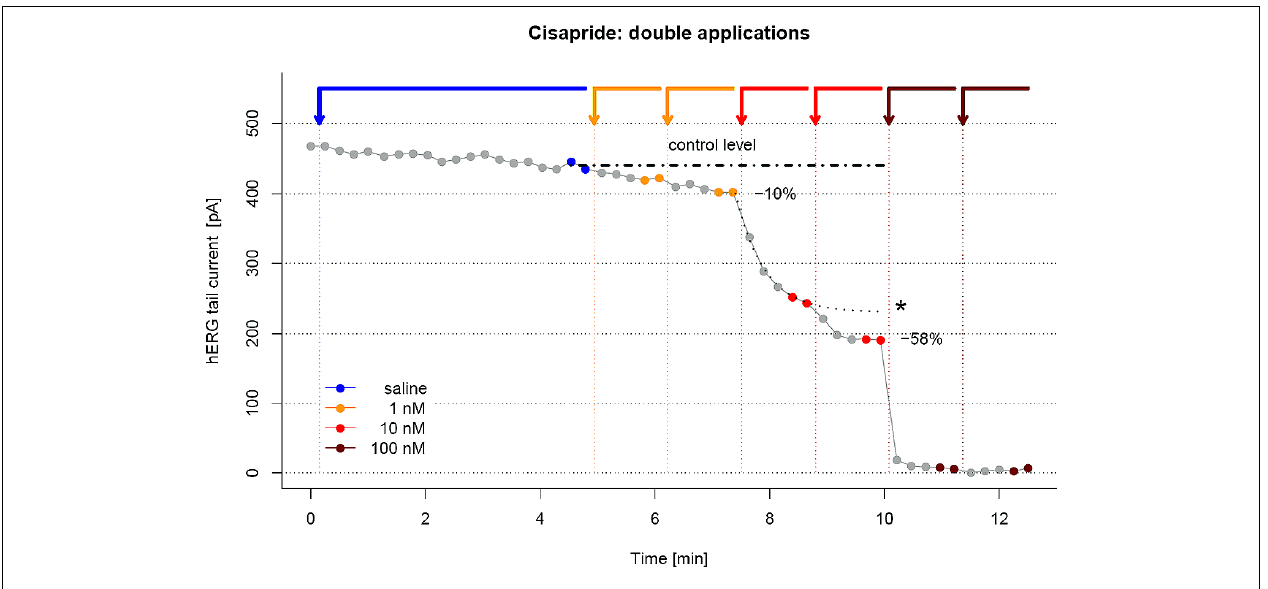
FIGURE 2 | Current vs. time (I/t) plot of a three point dose-response assessment of Cisapride on hERG currents. Downward arrows at the top of the figure mark time points where saline or test compound is applied, and horizontal bars indicate the duration of exposure.The last two data points